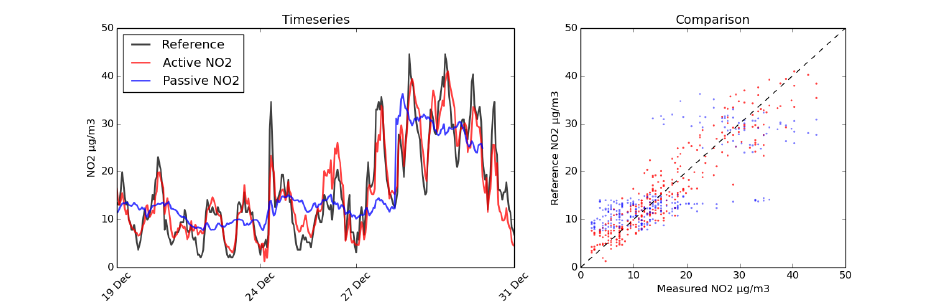
Figure 17. The effectiveness of aspiration (red) in comparison with the effectiveness of passive airflow for a sensor exposed to the elements (blue). The AURN (black) was used as a reference for actual NO concentrations. On the left is a time series; on the right is a scatter plot of the same data demonstrating the diminished sensitivity with passive airflow.